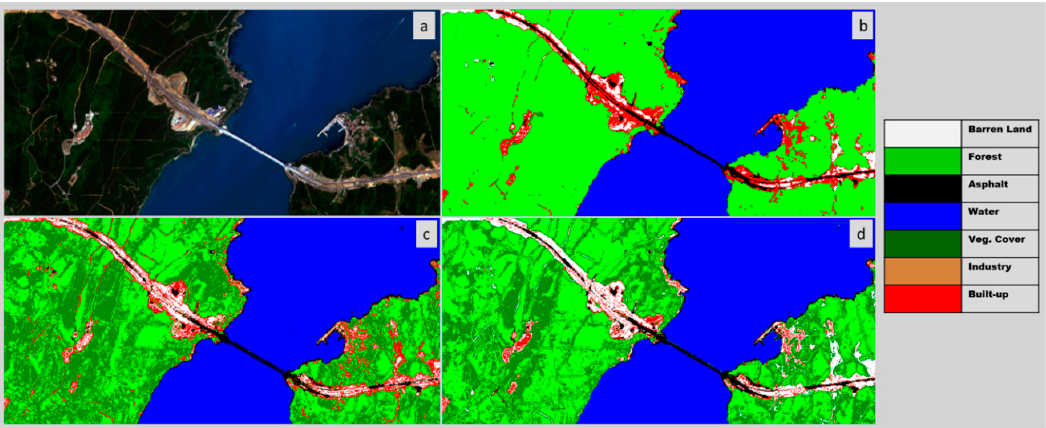
Figure 8. ( a ) RGB image of the Sentinel-2A; ( b ) the classified Sentinel-2A; ( c ) the classified multi-index (NDBI, NDVIre, and MNDWI); and ( d ) classified multi-index (NDTI, NDVIre and MNDWI) images.